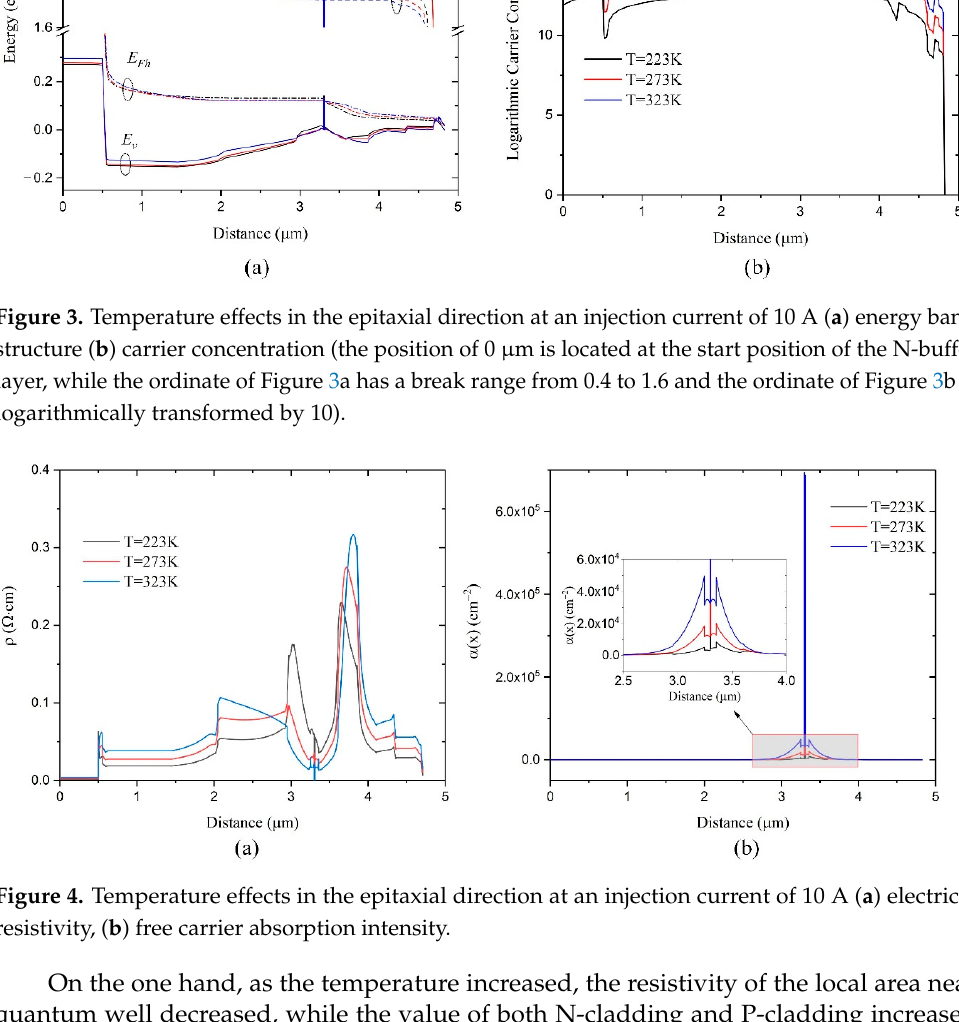
Figure 5. Temperature effects on Fermi energy level at an injection current of 10 A ( a ) electron Fermi energy level, ( b ) hole Fermi energy level. The carrier concentration in the quantum well was clamped over the threshold; how- ever, this clamped state was shifted by the temperature, as shown in Figure 6, which im- plied a nonlinear relationship between the threshold carrier concentration and tempera- ture. The threshold carrier concentration increased exponentially from 1.60 × 10 18 to 2.75 × 10 18 cm − 3 when the temperature rose from 223 to 323 K.